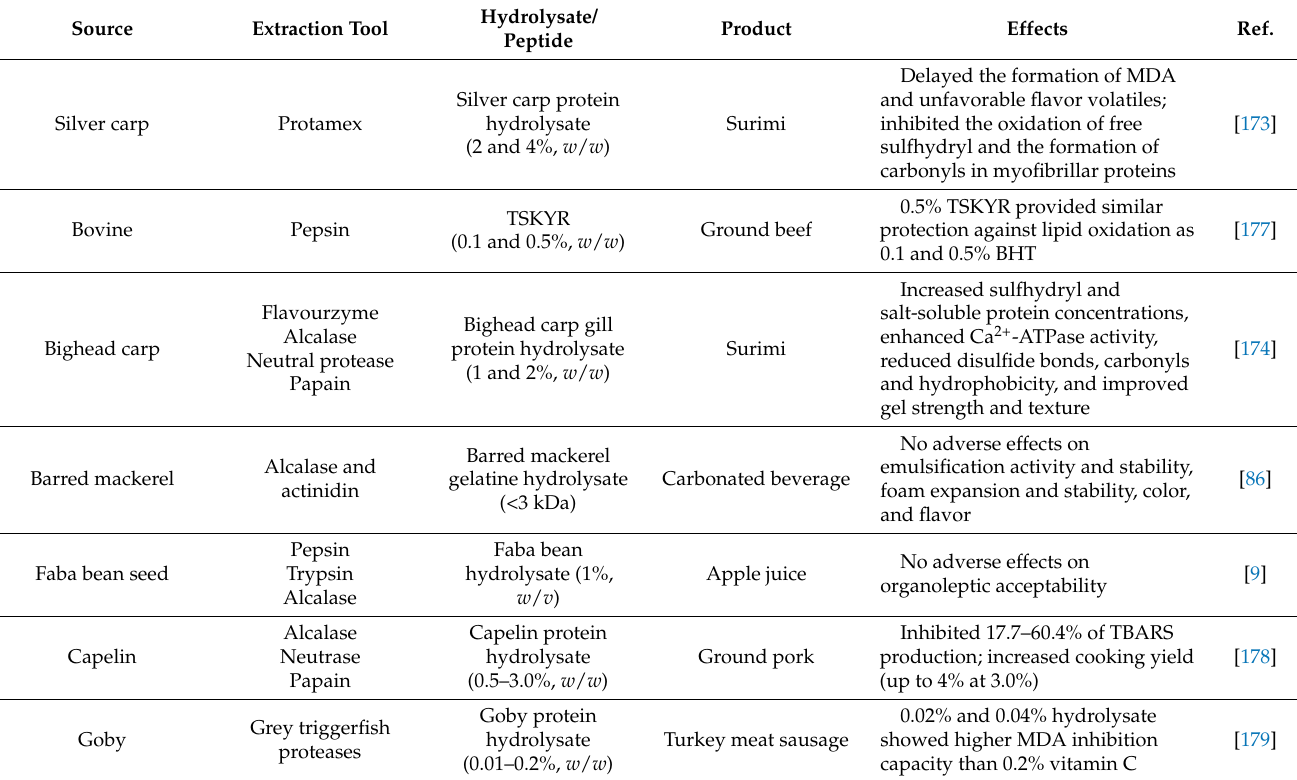
Table 4. the use of antioxidant protein hydrolysates (peptides) in food systems. Hydrolysate/ Source Extraction Tool Product Effects Peptide